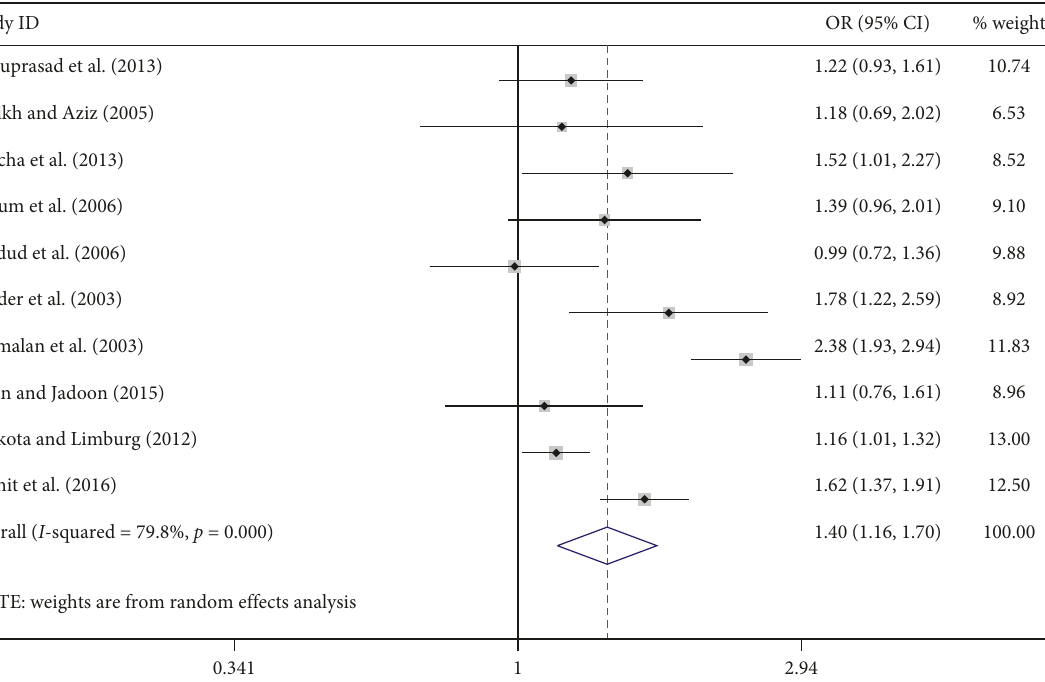
Figure 4: Forest plot showing the meta-analysis of CSC by sex on an eye basis at visual < 3/60 level. CSC � cataract surgical coverage; OR � odds ratio; CI � confidence